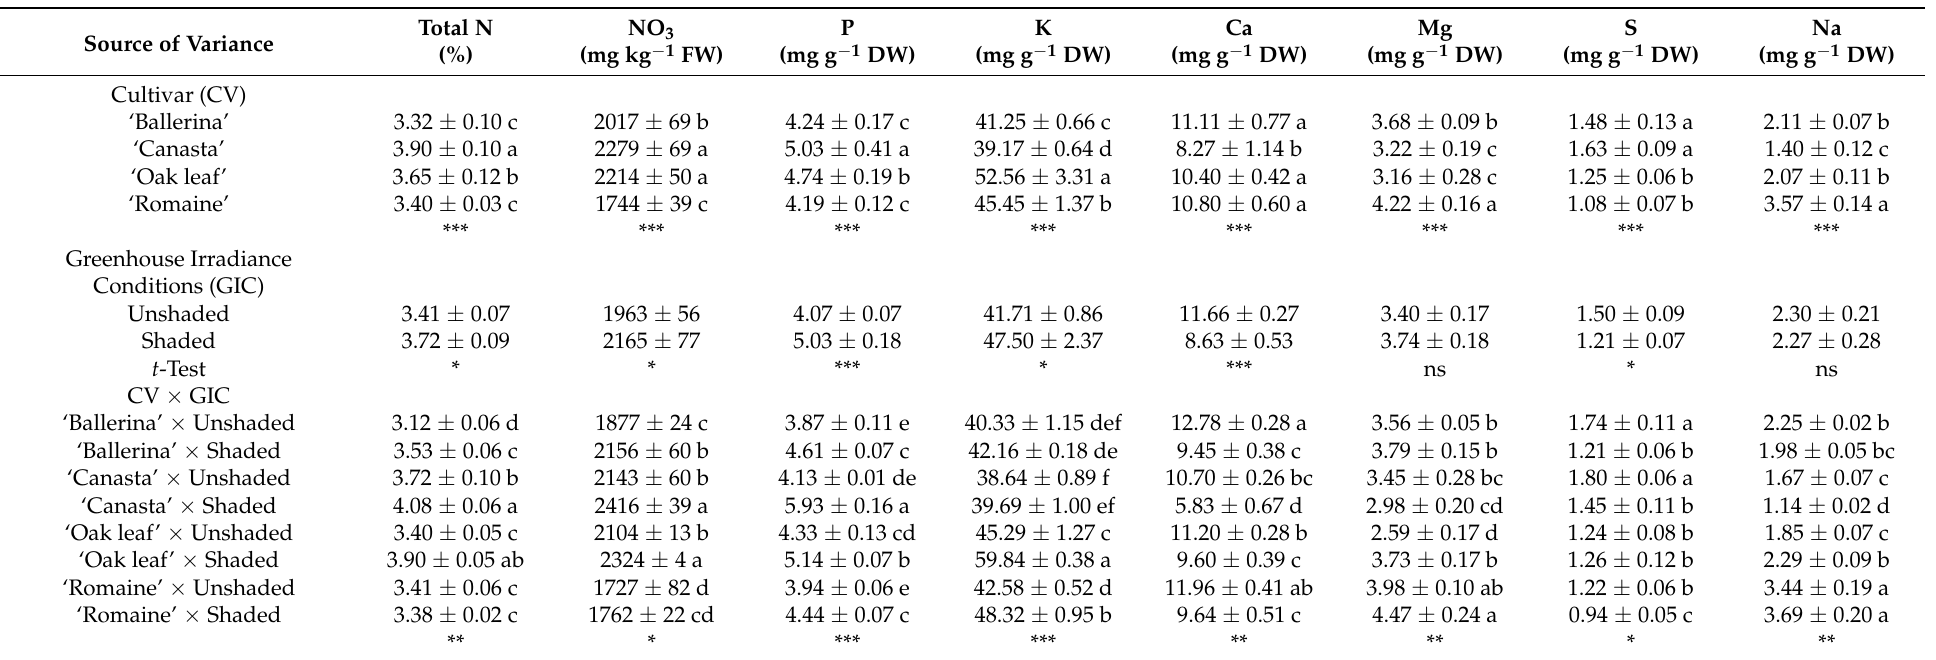
Table 2. Effect of cultivar and greenhouse irradiance conditions on total nitrogen and macronutrients accumulation in Lactuca sativa L. Source of Variance Cultivar (CV)